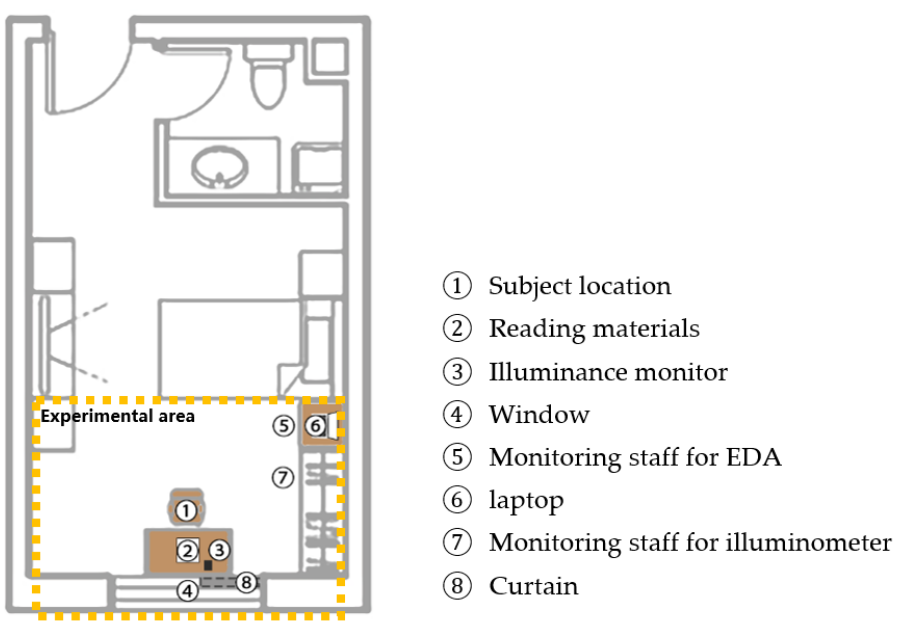
Figure 3. Experimental area